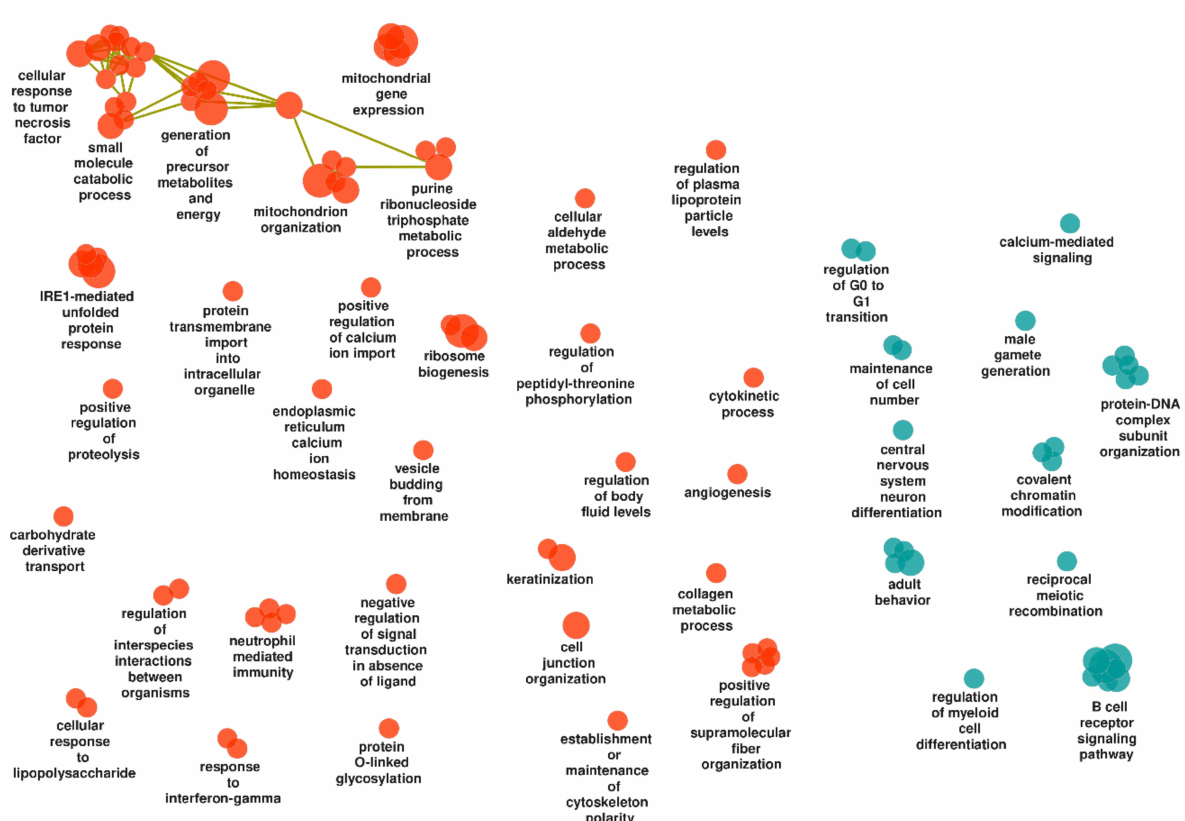
Figure 3. Gene ontology biological processes identified in non-inflamed UC mucosa compared to control mucosa and visualized as a functionally grouped network of gene sets that remain after ClueGO analysis. Orange and blue-green nodes represent upregulated and downregulated processes, respectively, and olive-green edges represent similarities based on gene content in each gene